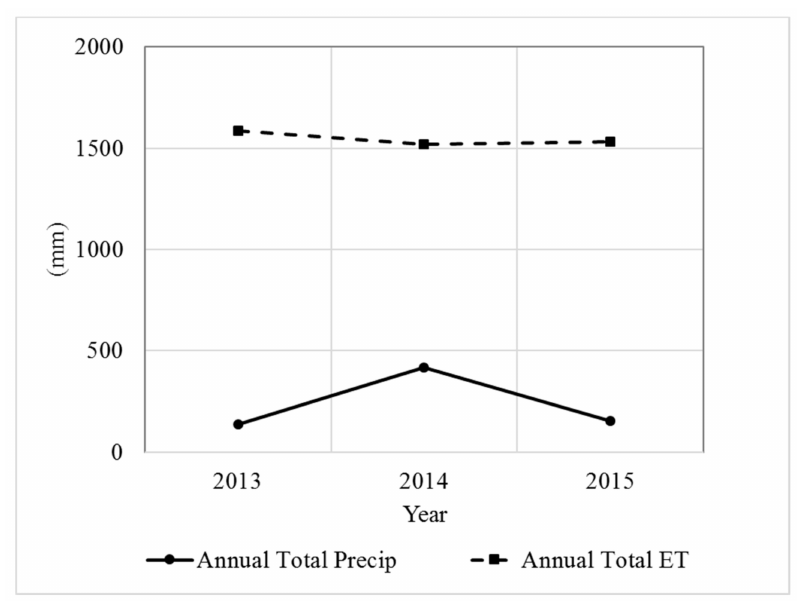
Figure 13. Total annual precipitation and evapotranspiration for the selected